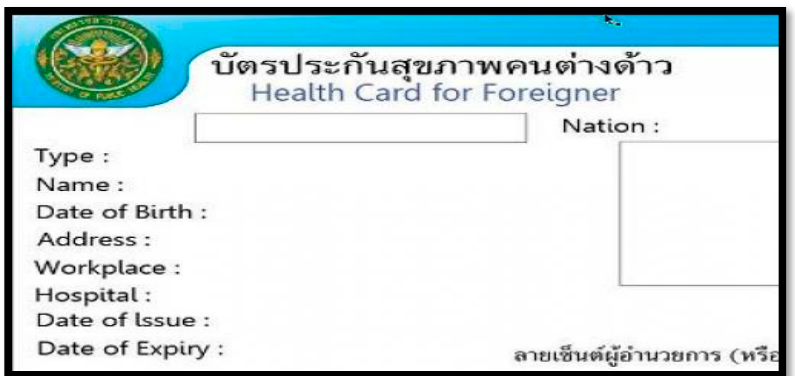
Figure 4. Picture of the health insurance card in 2013. Source: adapted from the MOPH [21].